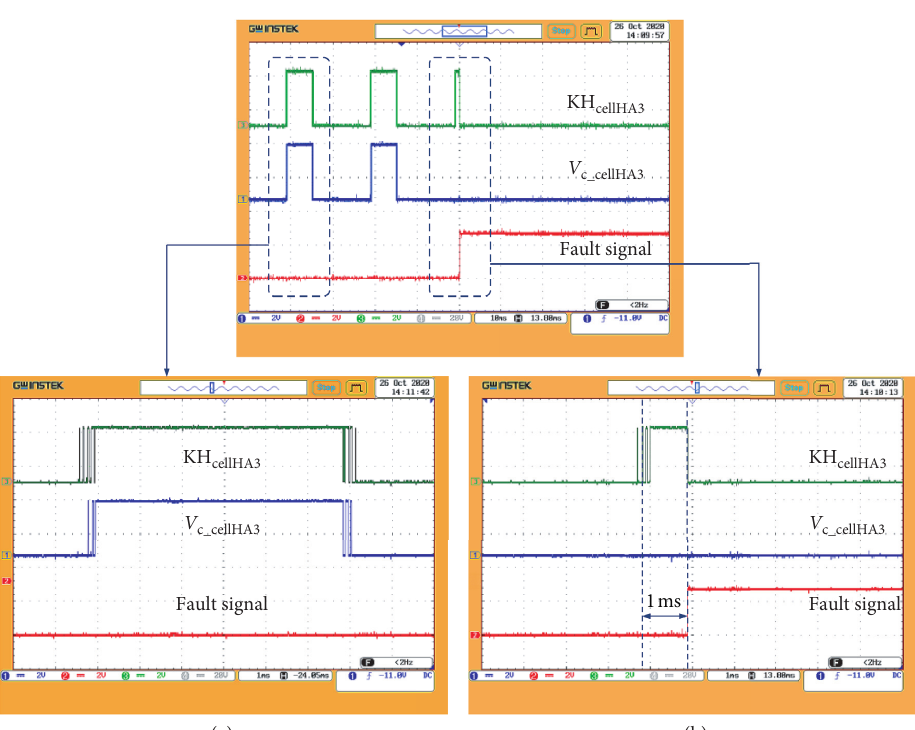
Figure 14: Waveforms of fault signal and KH